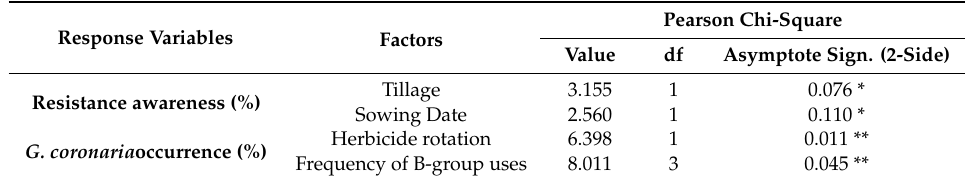
Table 2. Chi-Square test for dependency of grower awareness and G. coronaria occurrence to cultural and management practices in wheat field (Bizerte region).